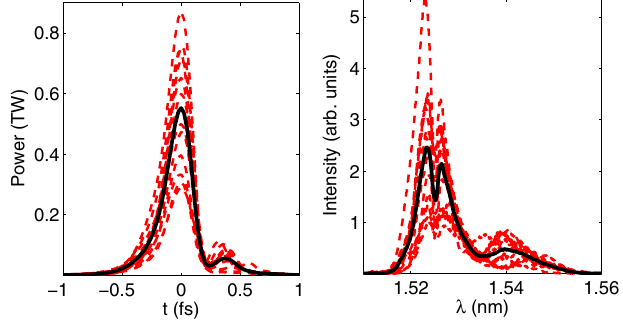
FIG. 4. Multiple-shot simulation results of FEL power profile (left) and spectrum (right) at the end of U2C undulator. The solid curves in the plots are the average over all shots.